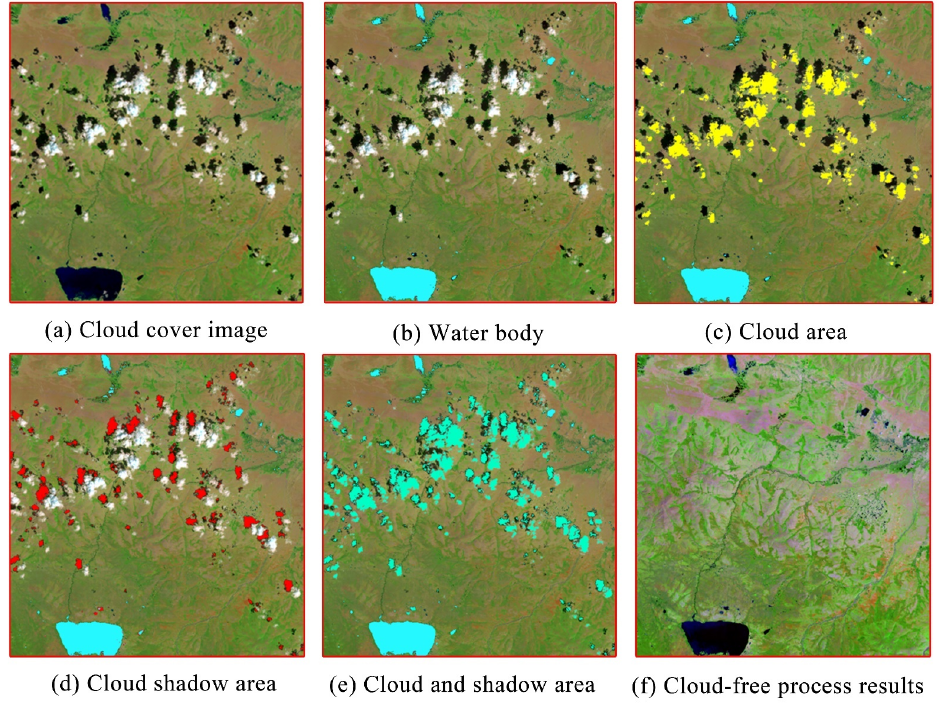
Figure 4. Cloud-free processes and the results of cloud-free calculation (17 July 2018, Path 135, Row 36 (WRS-2), ( a ) part).